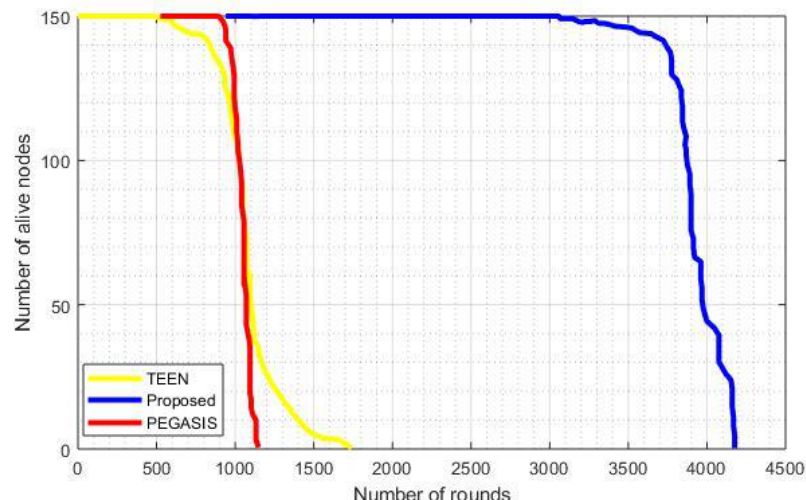
Figure 5. Number of rounds vs. number of alive nodes (150 nodes).